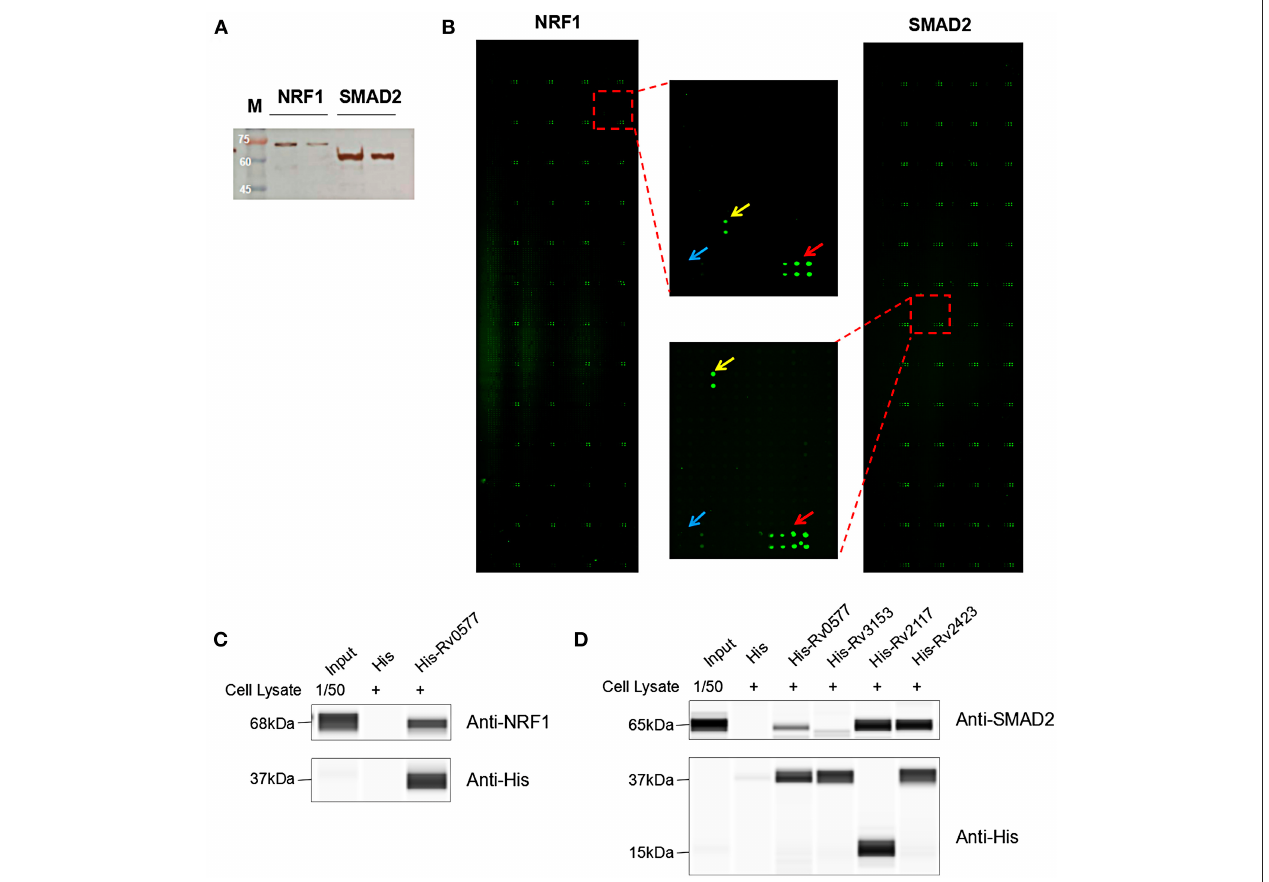
FIGURE 5 | The NRF1 and SMAD2 interactors identified on a Mtb proteome microarray and validation by His pull-down assay. (A) Silver staining to detect the purified NRF1-myc and SMAD2-myc. (B) NRF1 and SMAD2 binding study with Mtb proteome microarray. Each array contained Cy3 labeled BSA as a positive control (marked with red arrows) and BSA as a negative control (marked with blue arrows). Positive proteins were marked with yellow arrows. The cutoff for calling positive candidates was set as signal-to-noise (SNR) ratio ≥ 1.4 and Z-score ≥ 3.0. (C) His tagged -Rv0577 pull-down assay with endogenously expressed NRF1. (D) His tagged -Rv0577, -Rv3153, -Rv2117, and -Rv2423 with endogenously expressed SMAD2, respectively. Protein separation and detection were performed using an automated capillary electrophoresis system. The results are representative of two independent